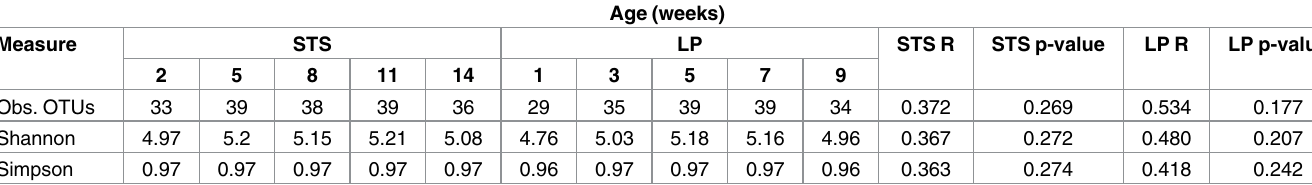
Table 2. Alpha diversity correlatedwith development age of chicks.